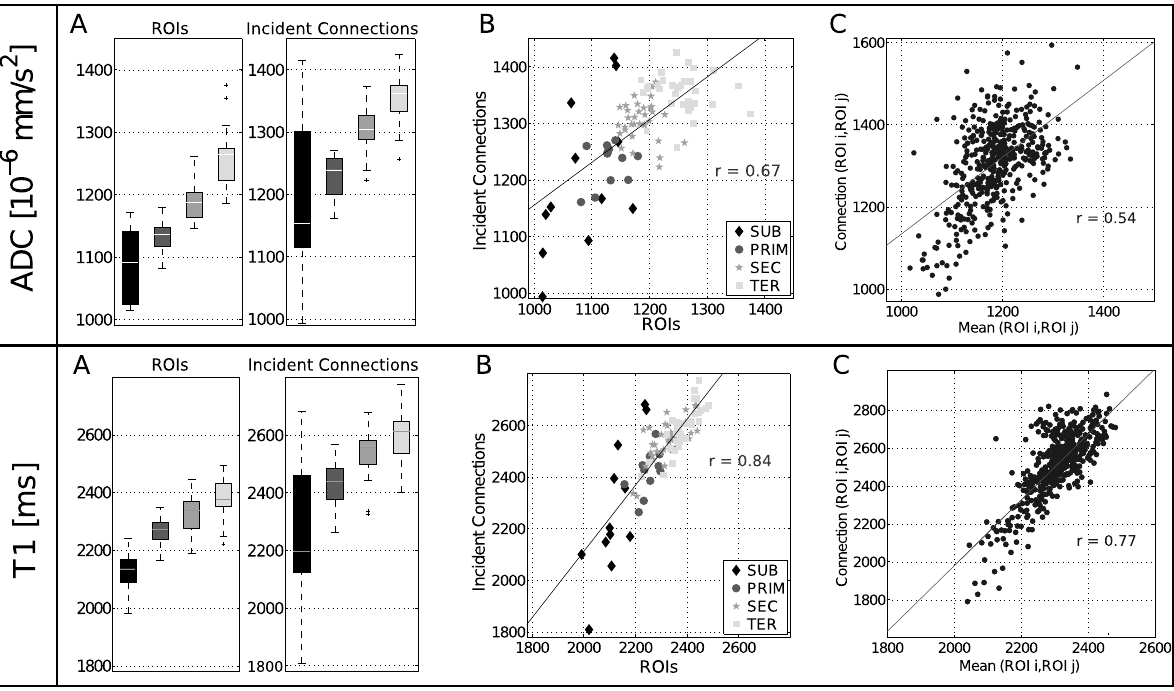
Fig 2. ROIs and incident connections. A: Distributionof ADC [10 − 6 mm/s 2 ] (top) and T1 [ms] (bottom) values for each ROI group and the incident connections. B: Scatterplot for ADC (top) and T1 (bottom) in ROIs and their incidentconnections, for all ROIs. Pearson’scorrelation: ADC r = 0.67, p < 10 − 10 ; T1 r = 0.84, p < 10 − 10 . Groups: SUB (n = 12) in black (diamonds), PRIM (n = 12) in dark gray (circles), SEC (n = 34) in gray (stars), TER (n = 32) in light gray (squares). C: Correlationbetweenmean ADC [10 − 6 mm/s 2 ] (top) and T1 [ms] (bottom) of GM ROI pairs and averageADC value along the connectingWM tracts (ADC: Pearson r = 0.54, p < 10 − 10 , T1: Pearson r = 0.77, p < 10 − 10 ; n = 450).